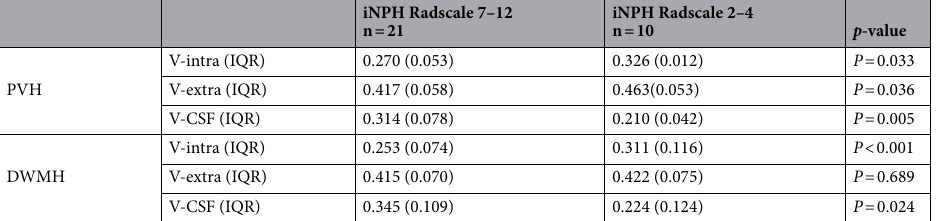
Table 2. PVH- and DWMH-ROI derived diffusion metrics. CSF = cerebrospinal fluid, DWMH = deep white matter hyperintensities, iNPH = normal pressure hydrocephalus, PVH = periventricular hyperintensities, V-CSF = free water/CSF fraction, V-extra = extraaxonal volume fraction, V-intra = intraaxonal volume fraction. Values are given as median and interquartile ranges (IQR).